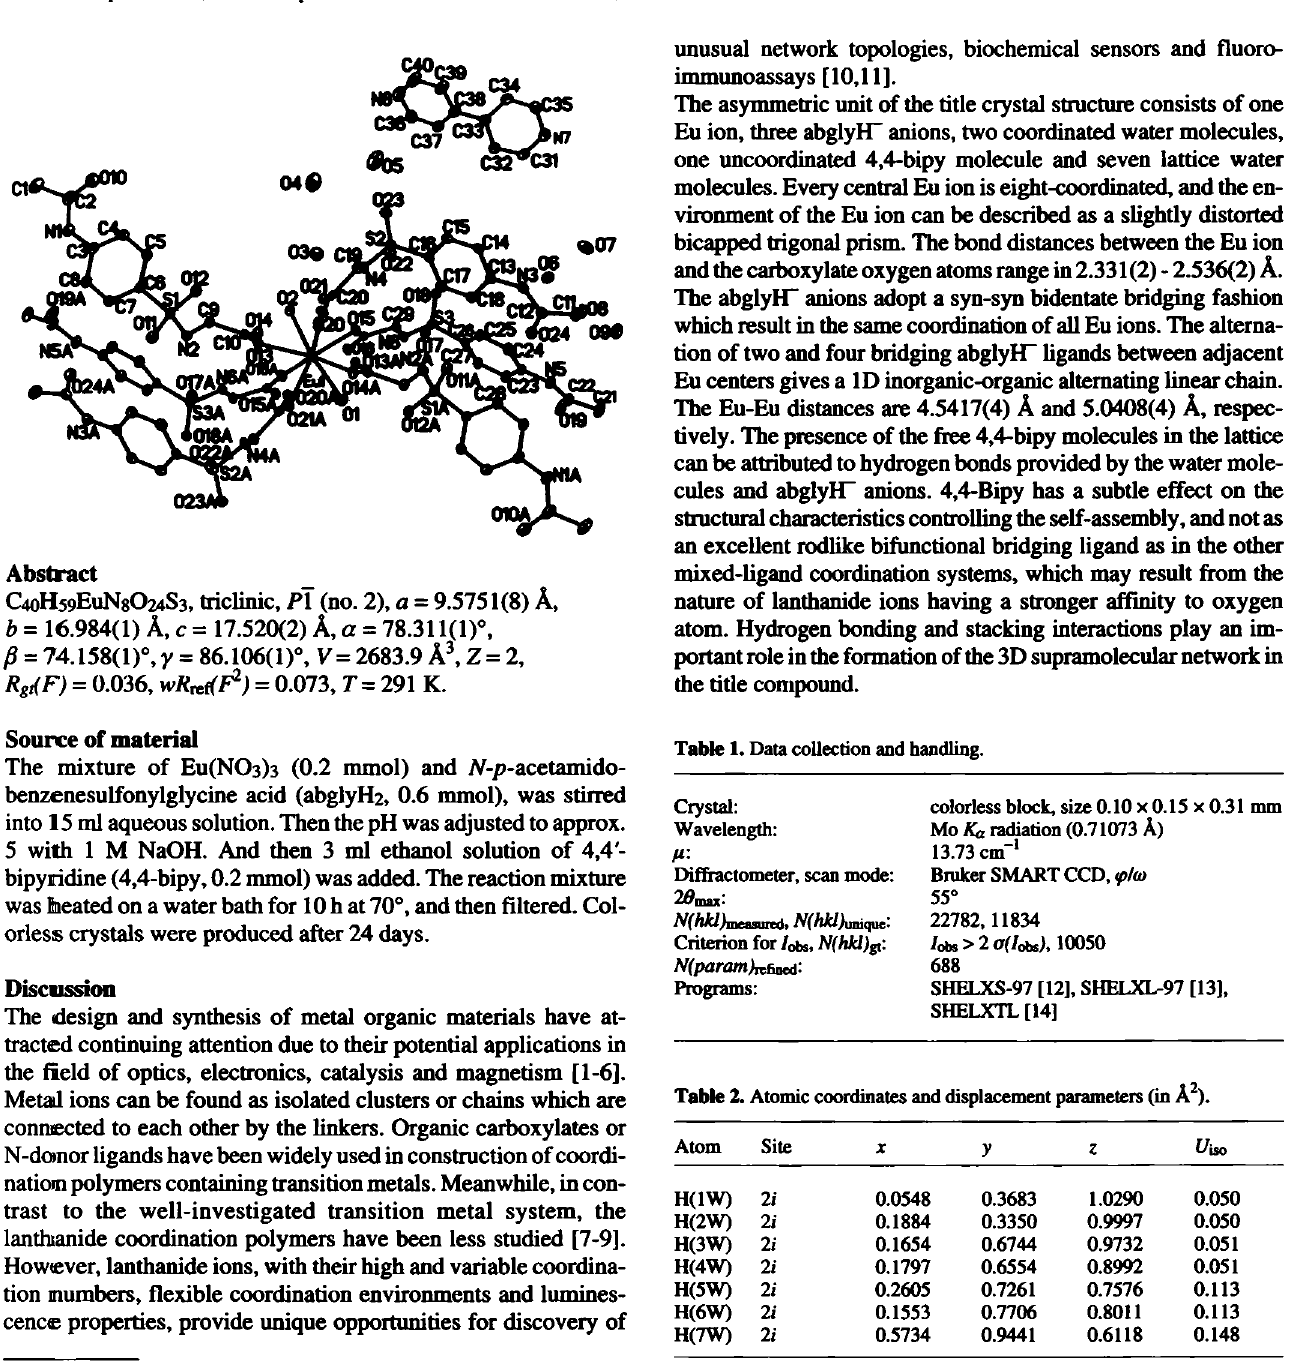
Table 2. Atomic coordinates and displacement parameters (in Â 2